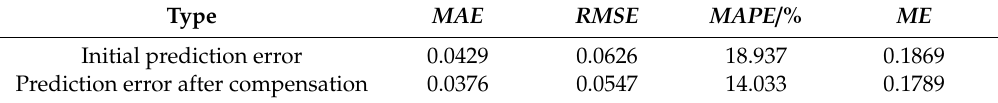
Table 4. Comparison of prediction error before and after compensation of wind power output.